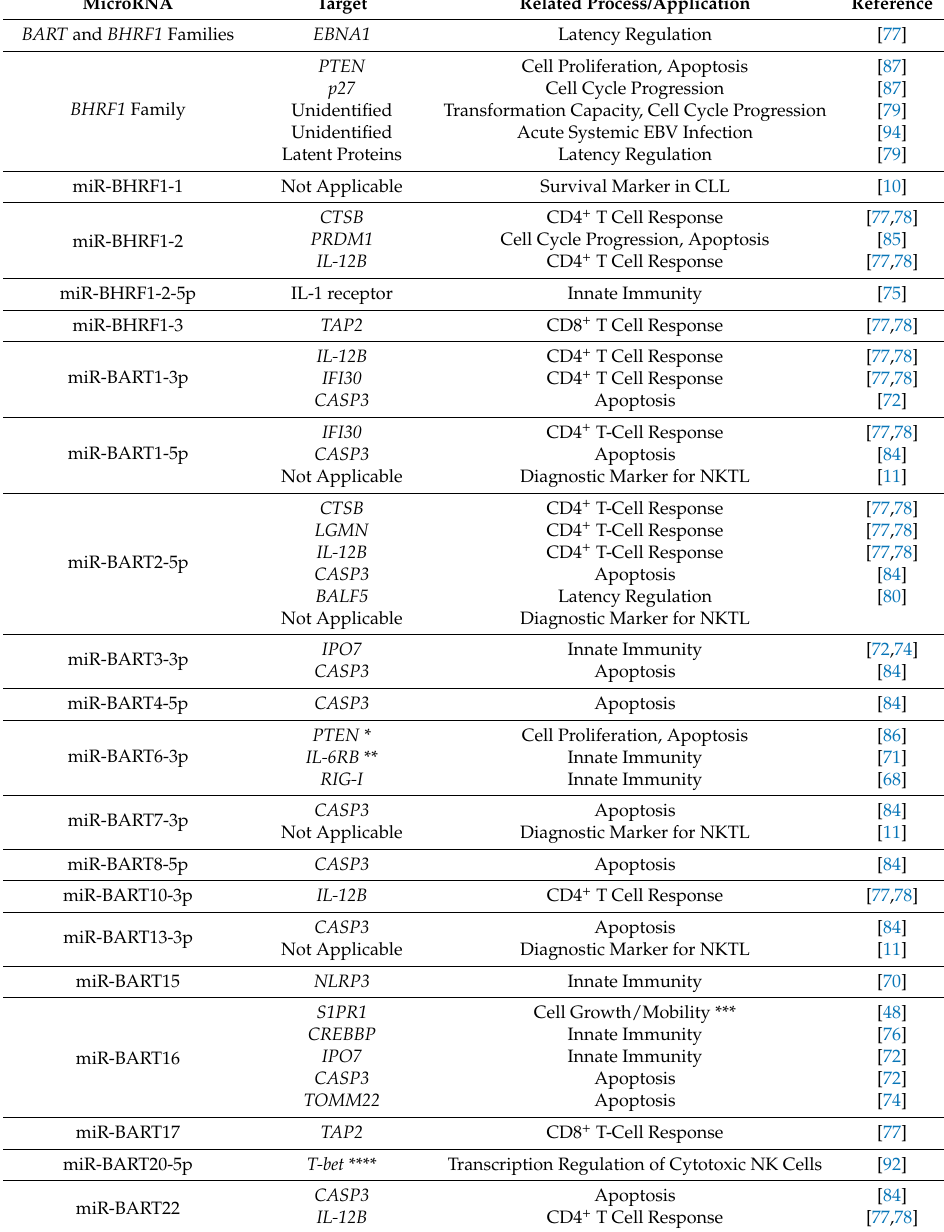
Table 2. A summary of the discussed EBV miRNAs and their